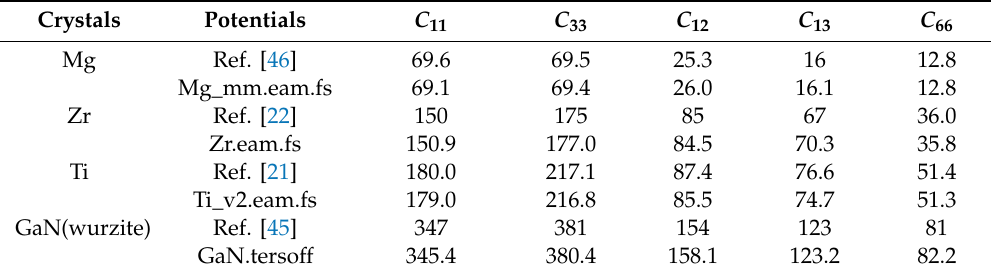
Table 2. Bulk elastic constants of hexagonal crystals (unit: